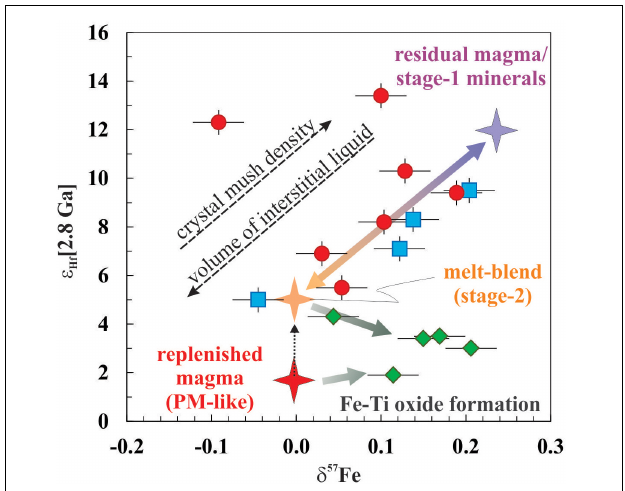
FIGURE 4 | Plot of stable Fe vs. age-corrected radiogenic Hf isotopes. Replenishing liquid (red star) with δ 57 Fe ∼ 0 and ε Hf (t) ∼ + 1 is admixed to liquid-in-residence, forming a new liquid (orange star). The Fe isotopes are a (cid:104) mixture between both liquids, whereas Hf is initially controlled by the liquid in residence. The final whole rock compositions of the samples, however, represent a mixture between minerals that formed from the liquid-in-residence (purple star) or stage-1 crystals that formed from it and newly formed minerals from the mixed liquid (orange star). Dependent on respective proportions, the whole rock will plot along the mixing trend. Magnetitites have probably retained a predominant memory of stage-1, Middle Zone liquid but will probably also record crystal chemistry affects in Fe